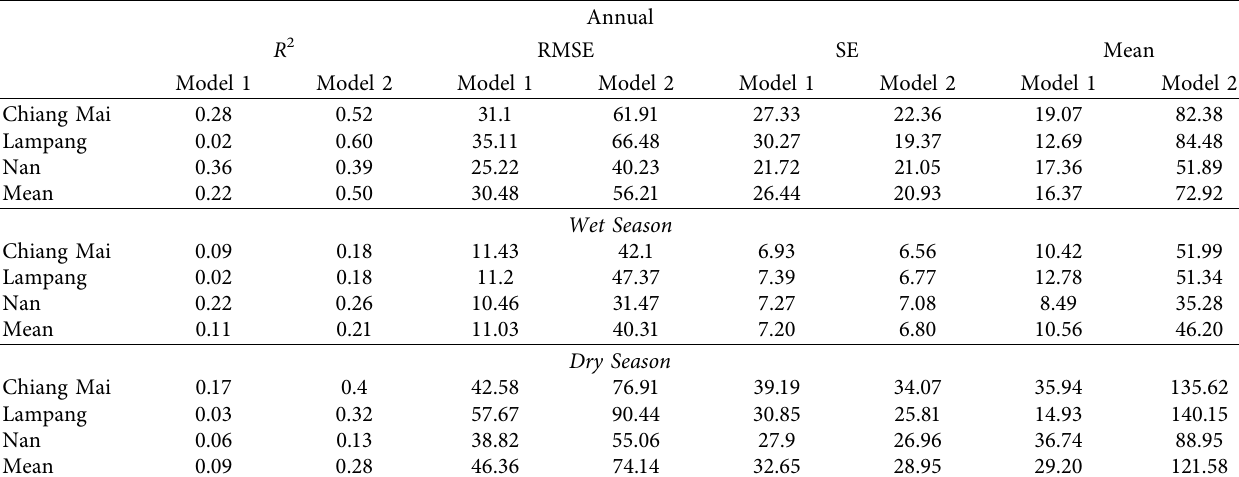
Figure 4: Fitting results of dry-season PM 2.5 data for (a–c) model 1 (generic) and (d–f) model 2 (multivariate linear Table 2: Summary of R 2 and error measure for fitting results.